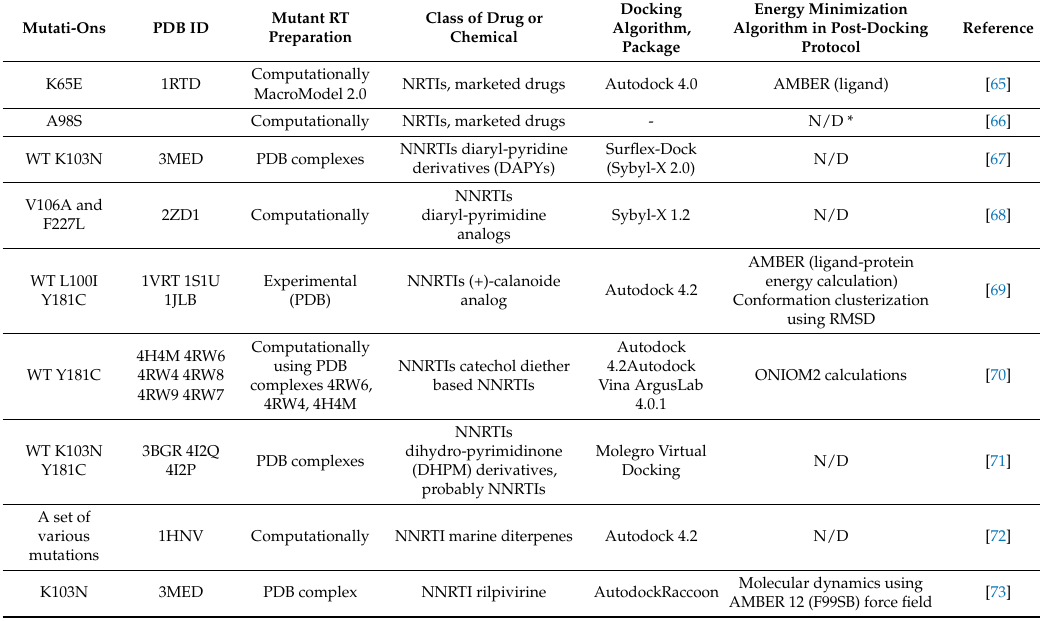
Table 3. Some examples of molecular docking applied to study HIV-1 resistance to NRTIs and